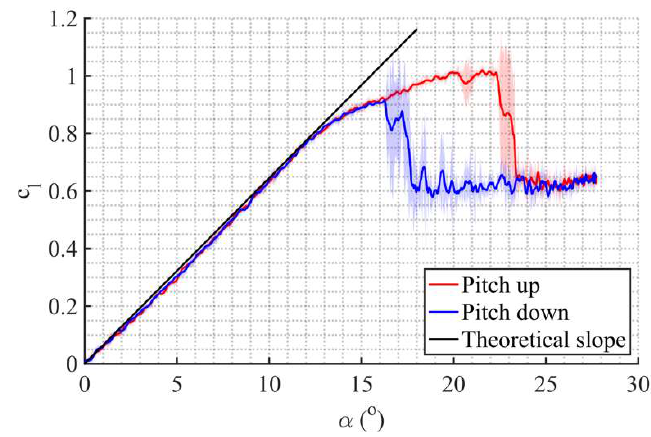
Figure 7. Quasi-static lift coefficient variation with pitch angle.